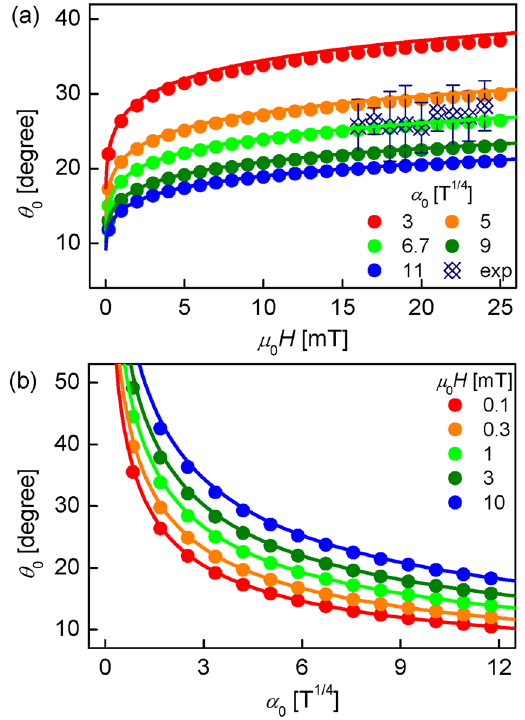
Figure 4. The dependence of θ 0 as a function of H and α 0 . ( a ) θ 0 with respect to H for various α 0 and ( b ) θ 0 with respect to α 0 for various H . The circular symbols are obtained by solving Eq. (2) numerically and the solid lines are from Eq. (3). The open symbols in ( a ) indicate the experimental data with the error bars are obtained by the root-mean-square error of the parabolic